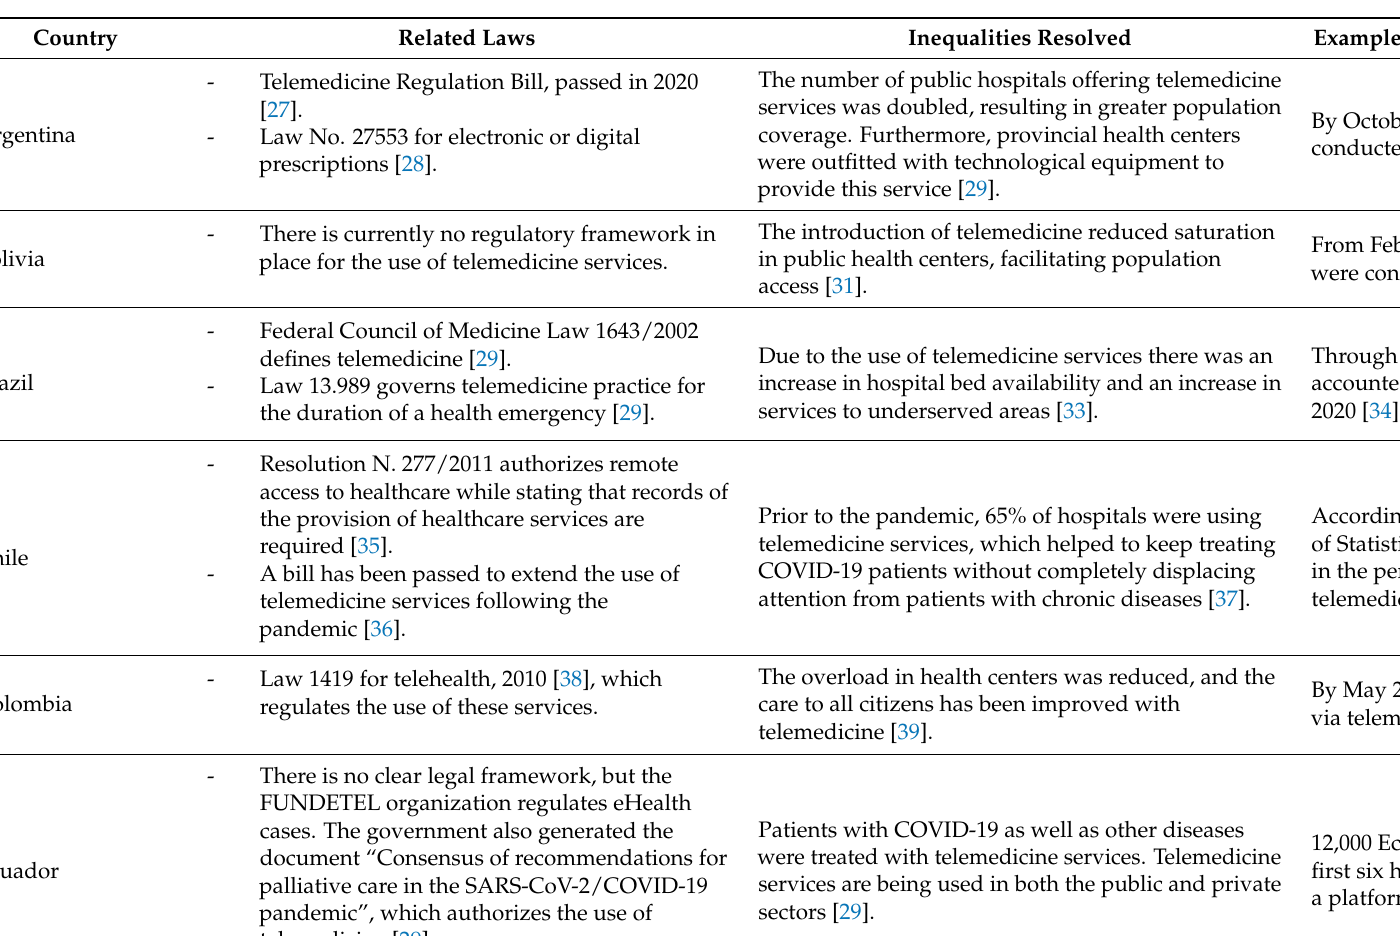
Table 1. Telemedicine laws, usage, and inequalities solved due to telemedicine in Latin American